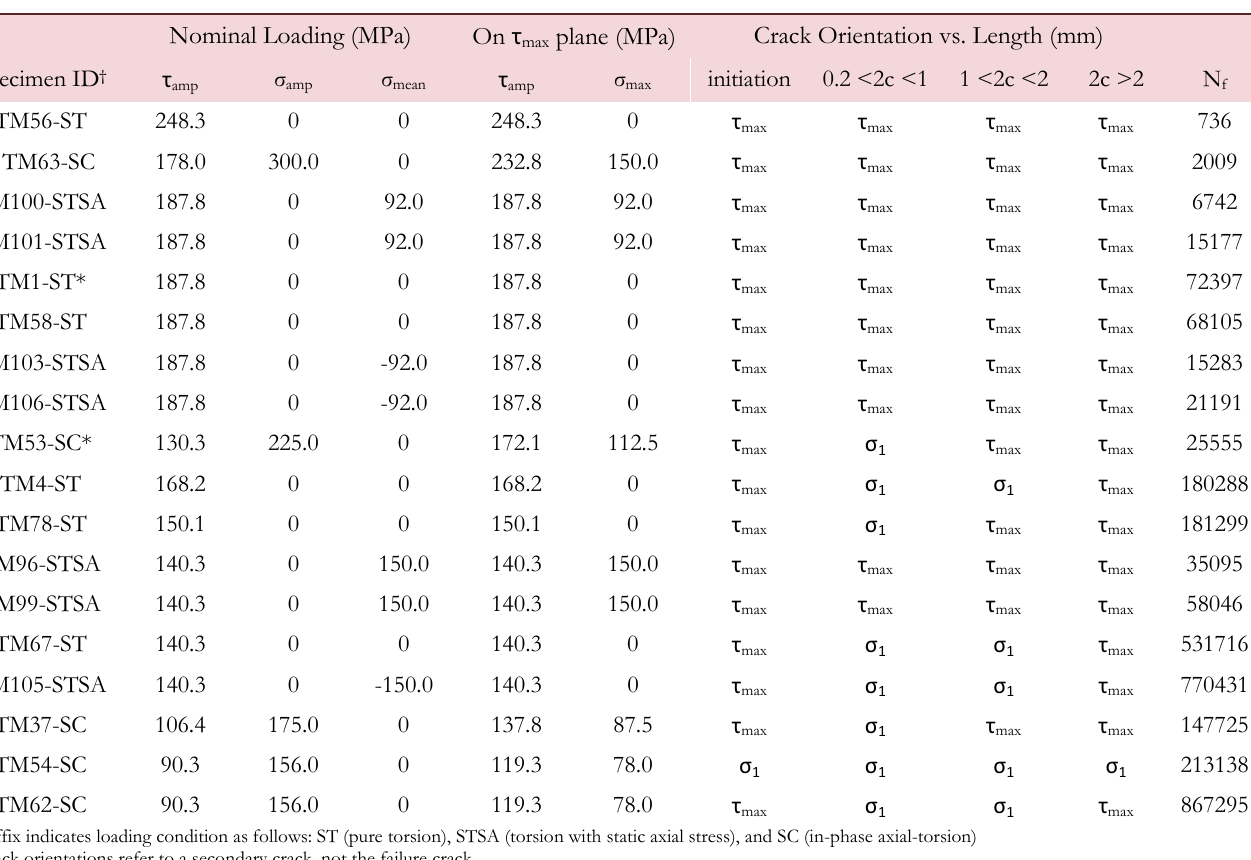
Table 1: Loading conditions, crack orientation vs. crack length, and fatigue life (to crack lengths of approximately 15-20 mm) for smooth specimen fatigue tests. All stresses are given in MPa and all crack lengths are given in